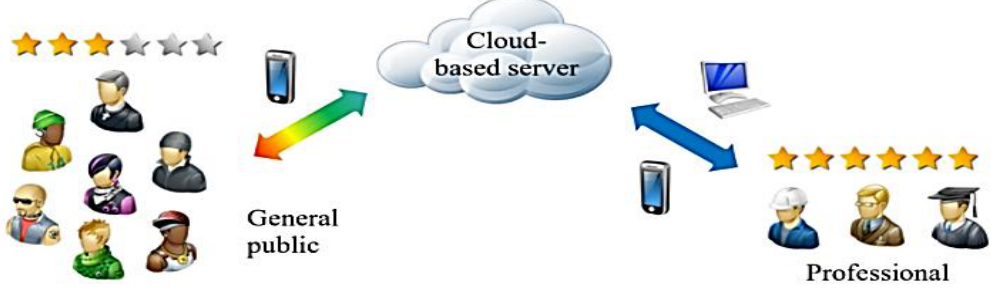
Figure 23. App Implementation.